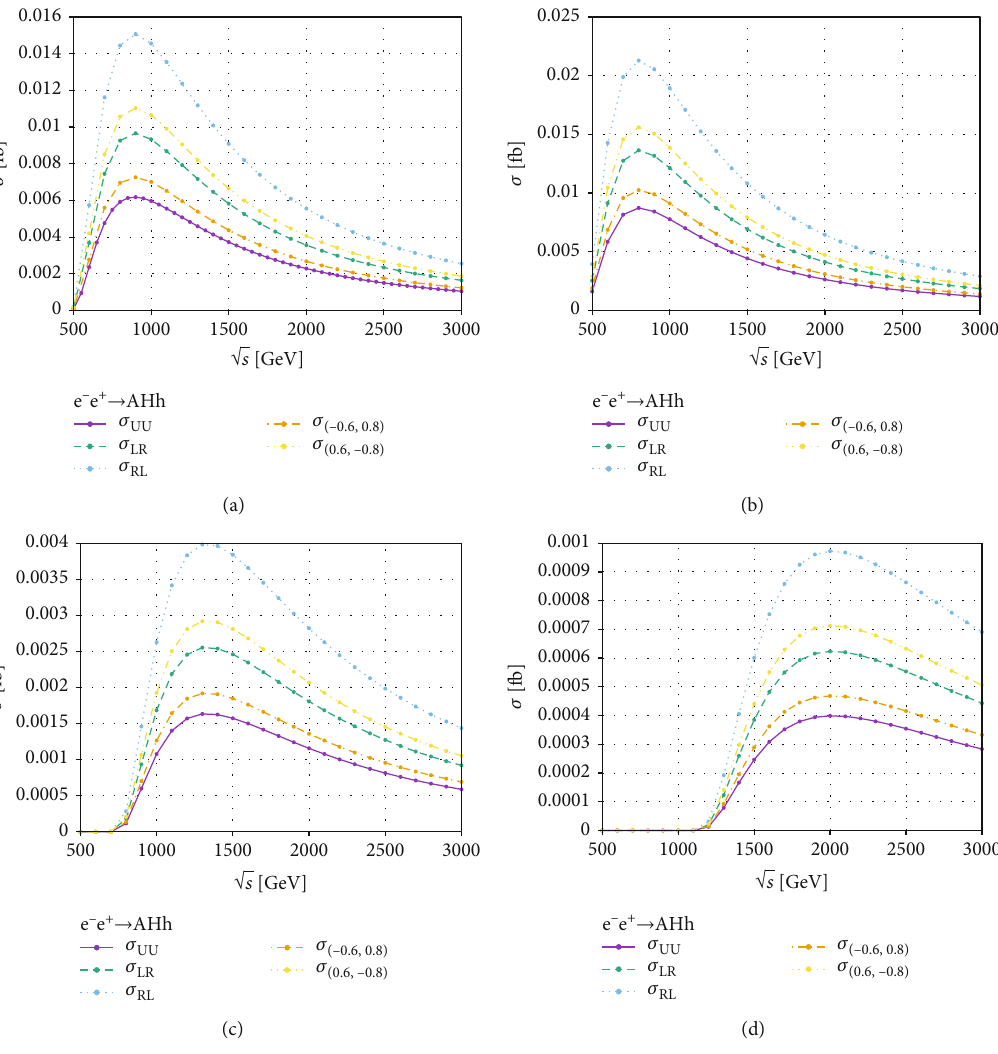
Figure 13: The distribution of cross-section σ ( fb ) as a function of 175GeV, 300GeV, and 500 GeV at tan β = 10 and s βα = 1 are used in fi gures (a), (b), (c), and (d),